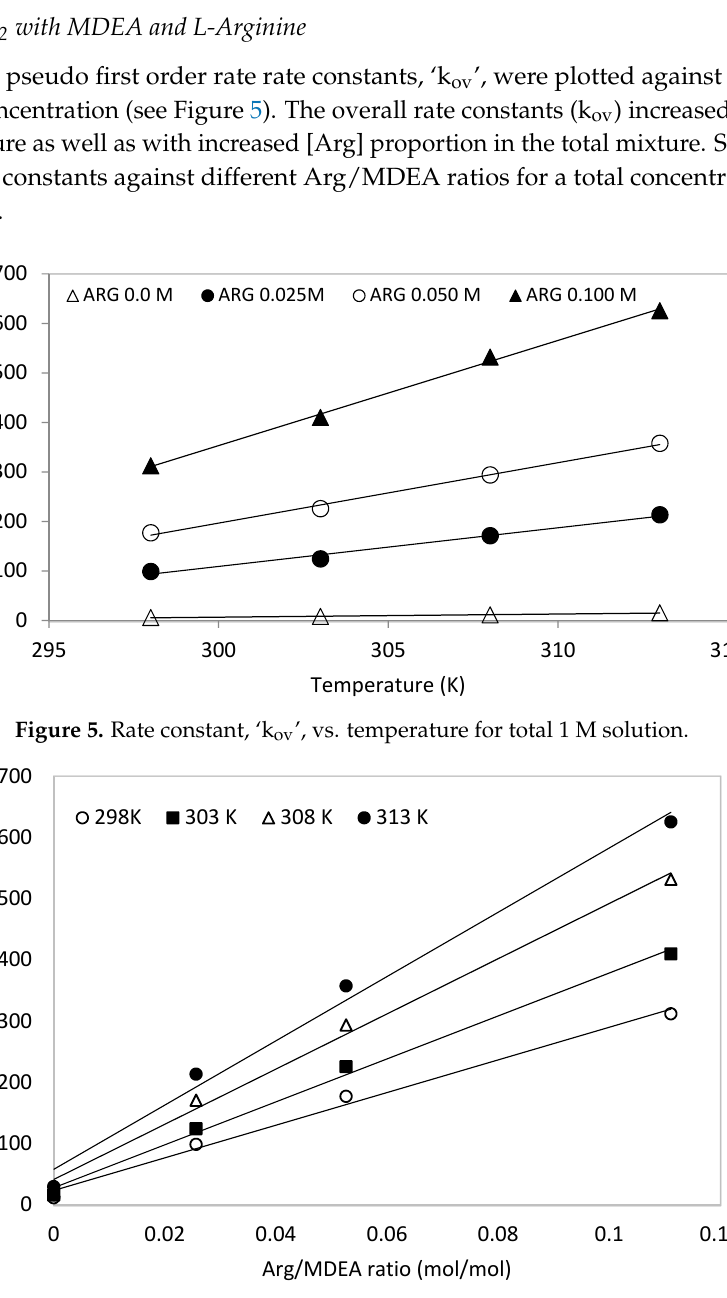
Figure 4. Typical Experimental run for MDEA-Arg at 303 K.